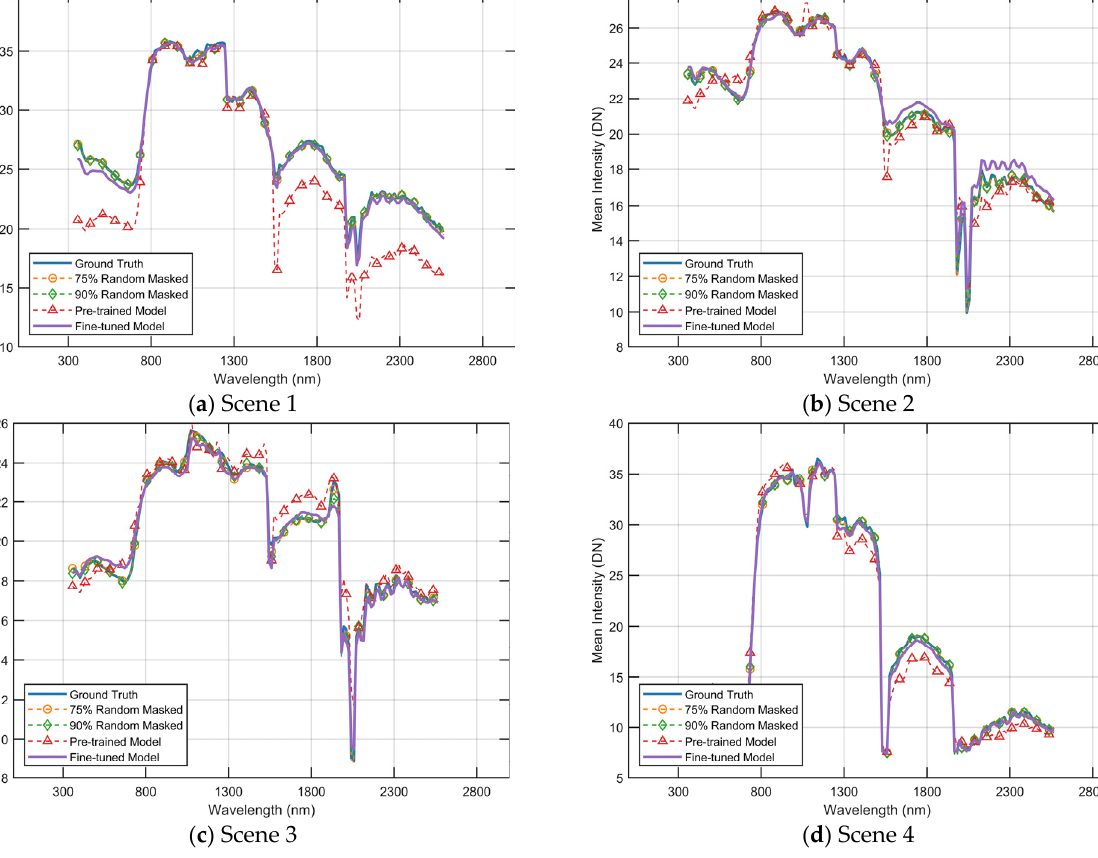
Figure 11. Reconstructed spectral curves comparisons of scenes shown in Figure 9 on the GF2Hyper dataset. The spectral curves were averaged in the spatial dimension of the images. DN is a digital number (uncalibrated) between 0 and